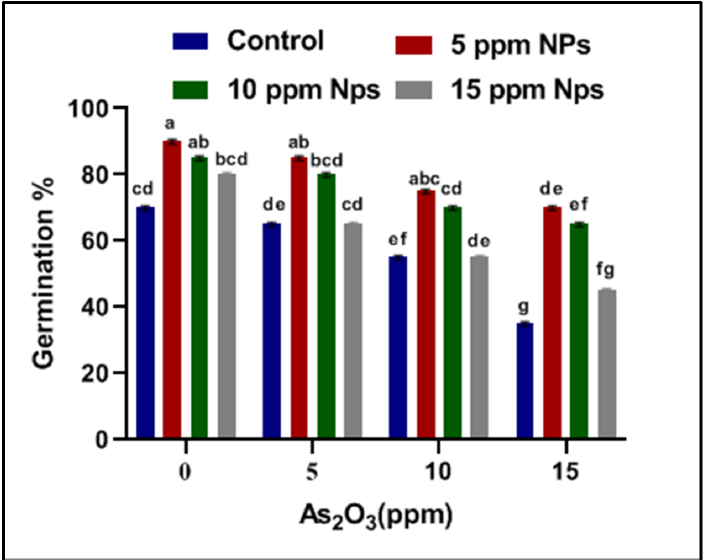
Figure 2. Effect of Bacillus subtilis -synthesized Fe 3 O 4 NPs on “seed germination (%)” of rice ( Oryza sativa L.) in arsenic-contaminated water. Different letters show a significant difference at p < 0.05 between treatment .